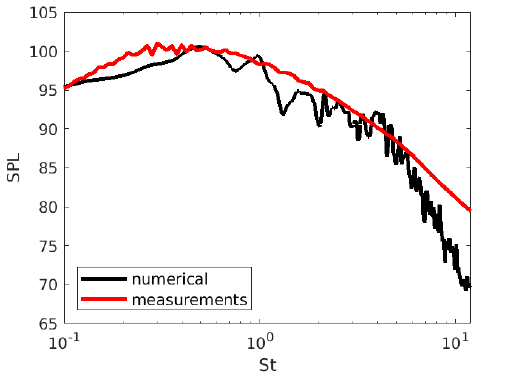
Figure 10. Comparison between numerical results and measurements (Bridges et al. [40]). In general, the effect of trailing edge deformation on the radiated noise was small. We noticed both an increase and a decrease in noise, depending on the combination of amplitudes and wavenumbers characterizing the deformations. A visible reduction in noise was achieved for treatment 5 given in Table 2 ( w z = 4, A = 0.14). The acoustic spectra at the three probe points are plotted for this case in Figure 11a–c.